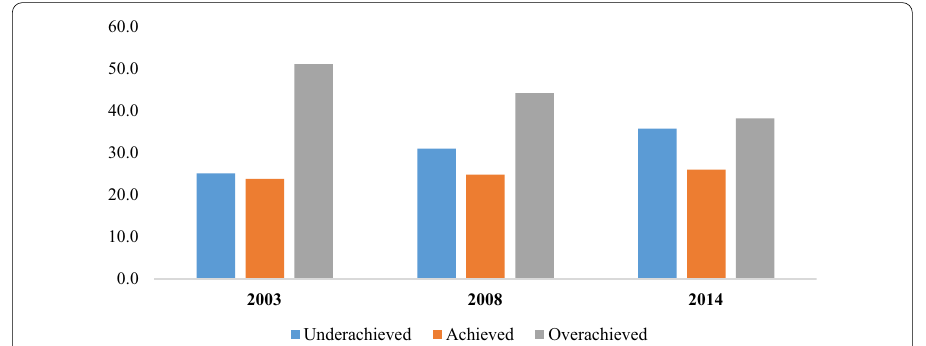
Fig. 1 Trends in fertility gap among women with completed fertility Source: Generated from the GDHS 2003, 2008 and